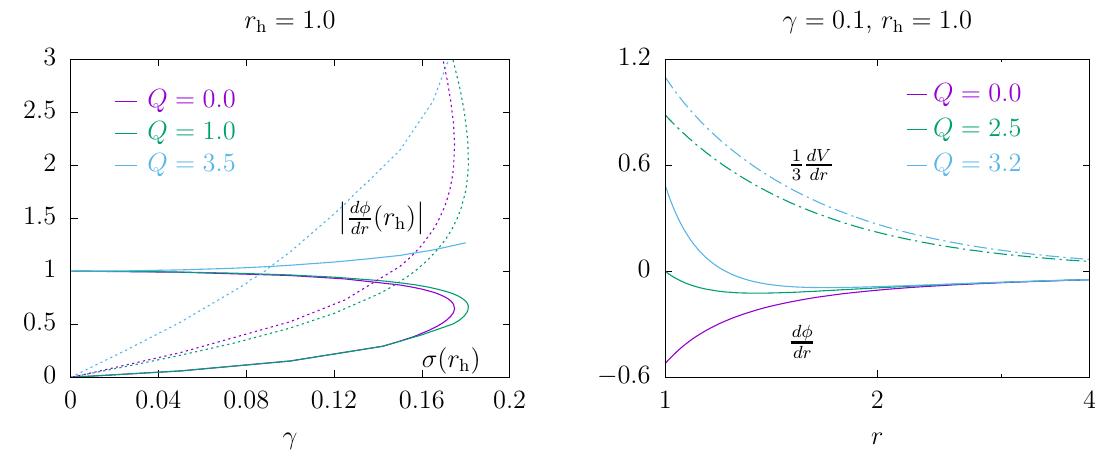
d(cid:30) ( r h ) (dashed) for di(cid:11)erent values of the charge dr (cid:12) (cid:12) (cid:12) (cid:12) (cid:12) (cid:12) 3. Right: the pro(cid:12)les of the derivative of the scalar (cid:12)eld function (cid:0)